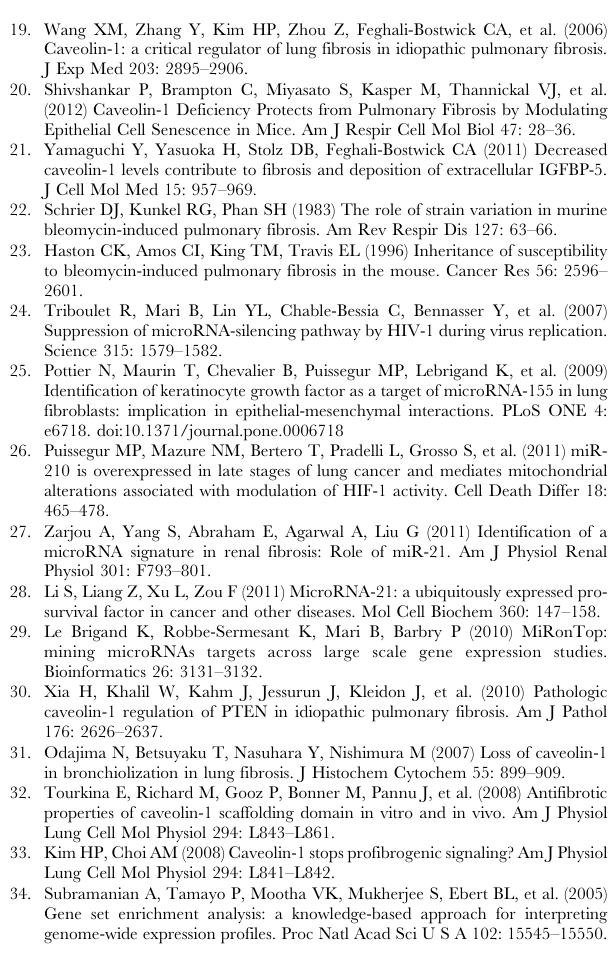
Table S1 List of themes corresponding to ‘‘canonical pathways’’ annotations identified by Ingenuity Pathway Analysis in response to overexpression of miR-199a-5p or miR-21 in human pulmonary fibroblasts hFL1. Normal human pulmonary fibroblasts hFL1 were transfected with pre-miR-Neg, pre-miR-199a-5p or pre-miR-21 (n=2). RNA samples were harvested at 48 h post-transfection and expression profiles were determined with whole genome micro- arrays. The probability to obtain the number of genes in a certain pathway in the list of differentially expressed genes between either miR-199a-5p or miR-21 versus miR-Neg was compared with the representation of the same pathway among all the genes on the microarray; 2 log10 of the Fisher’s exact probability is indicated. Significant pathways are shown in progressively brighter shades of orange according to their significance. ns=non significant. Table S2 List of themes corresponding to ‘‘canonical pathways’’ annotations identified by Ingenuity Pathway Analysis in lungs from C57BL/6 mice treated with bleomycin. RNAs extracted from C57BL/6 mice lungs 14 days after instillation with bleomycin or PBS were analyzed with whole genome microarrays (n =5).The probability to obtain the number of genes in a certain pathway in the list of differentially expressed genes between bleomycin and PBS conditions was compared with the represen- tation of the same pathway among all the genes on the microarray; 2 log10 of the Fisher’s exact probability is indicated.